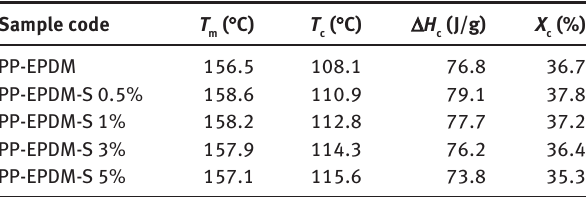
Table 3 Thermal characteristics of